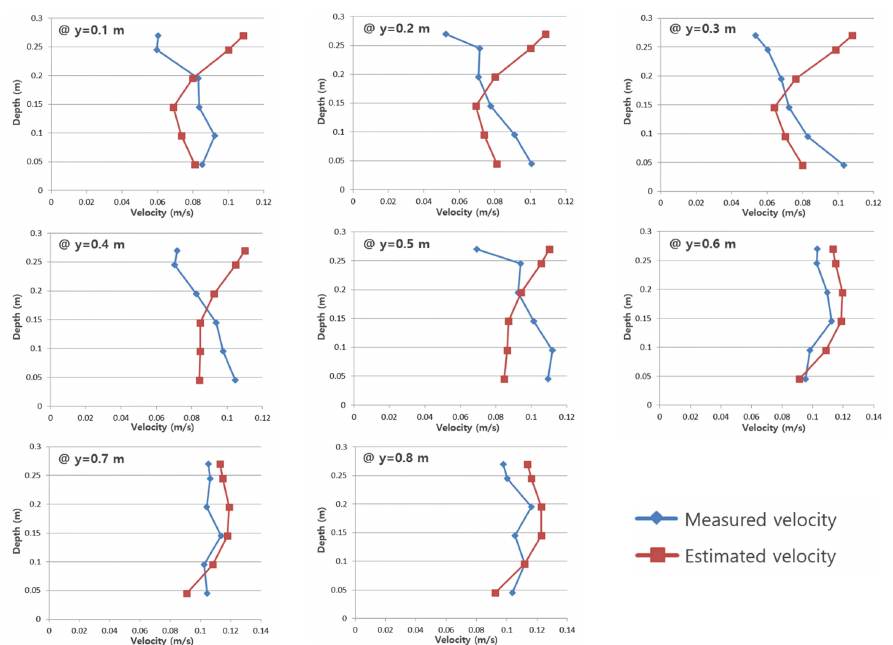
Figure 5. Comparison between measured velocity (blue line) and that estimated by Equation (7) (red line) in laboratory meandering channel at Section U1 (y denotes lateral coordinate from left to right bank).